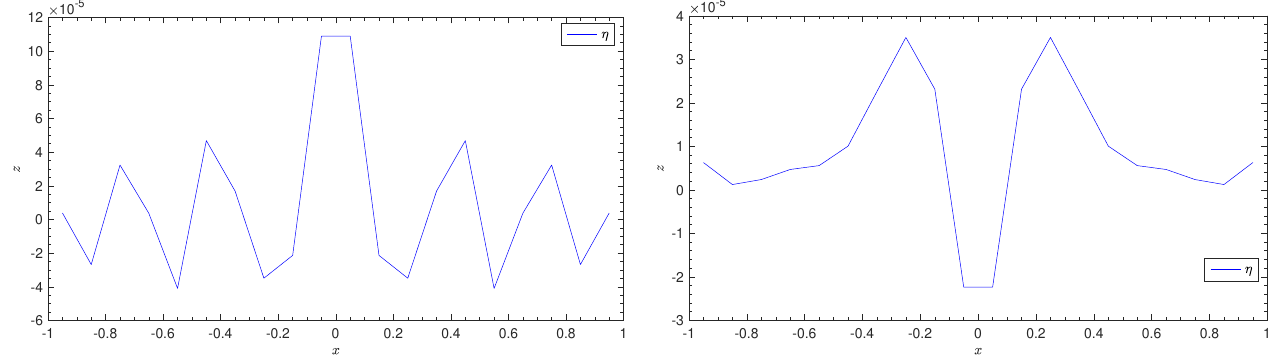
Figure 7. Computed free surface of the smaller perturbed stationary solution (53) (sallow-water equations) with the fourth order non well-balanced ( left ) and well-balanced ( right ) Runge–Kutta DG method at t = 0.5 s. A coarse uniform Cartesian mesh of N x = 20 elements has been